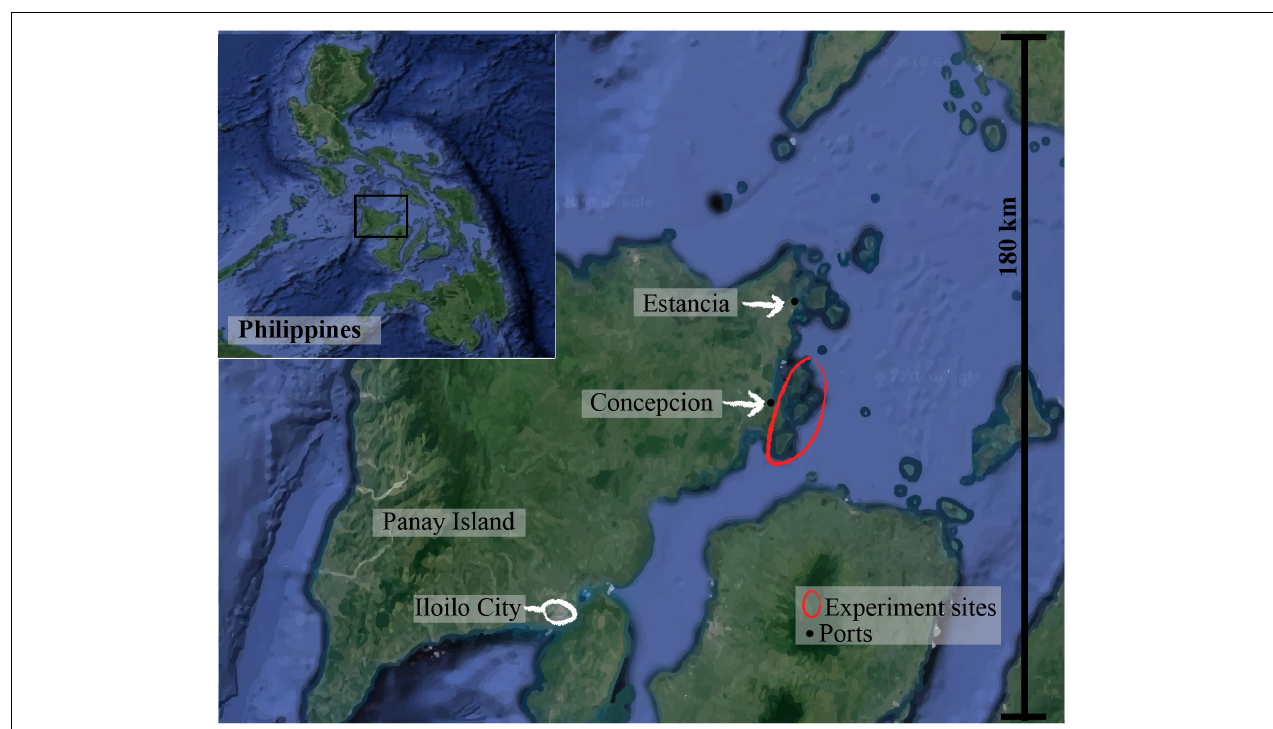
FIGURE 2 | Panay island location in Philippines (inset). The Capital of the main province on Panay Island, Iloilo, can be seen circled in white to the south- Iloilo City. Concepcion is located on the North Eastern seaboard as is Estancia- the other major, and larger fishing port and town to the North of it. The area where the experimental sites are is circled in red.